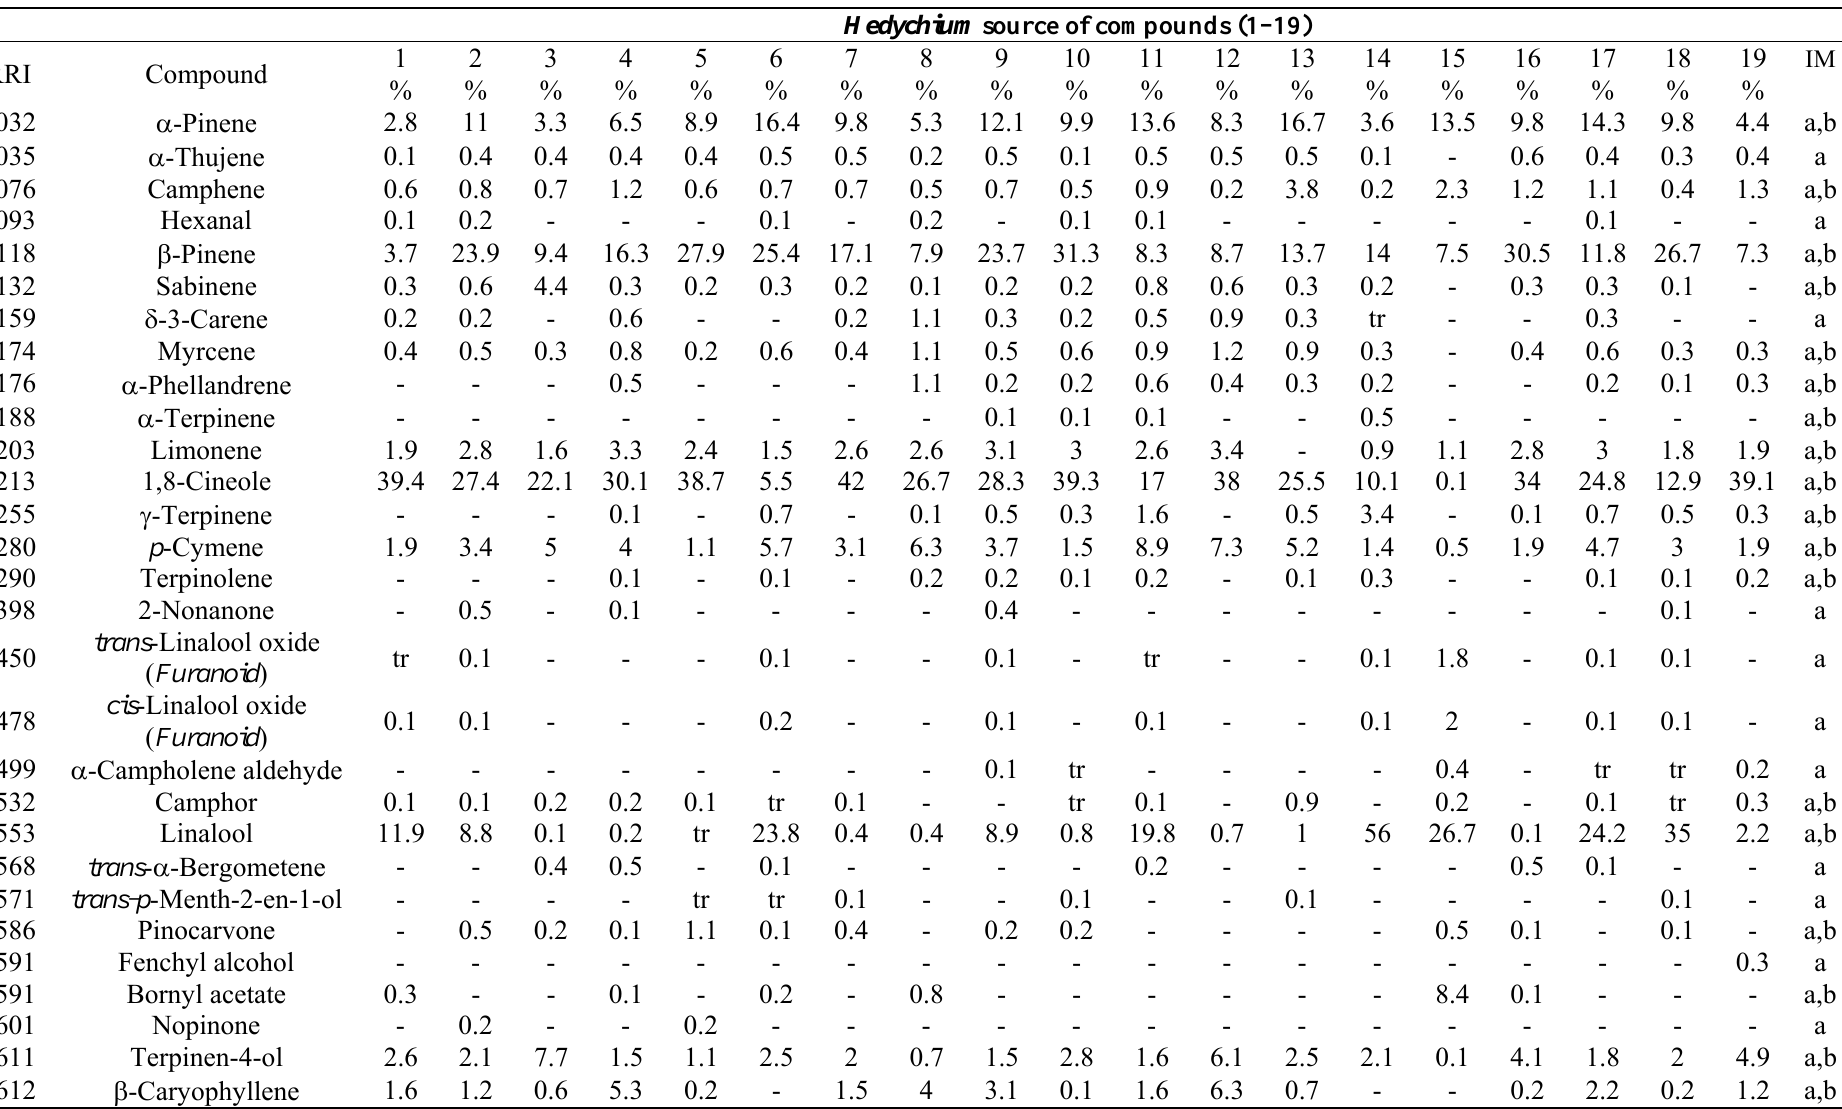
Table 1. Chemical composition of essential oils from different Hedychium species and